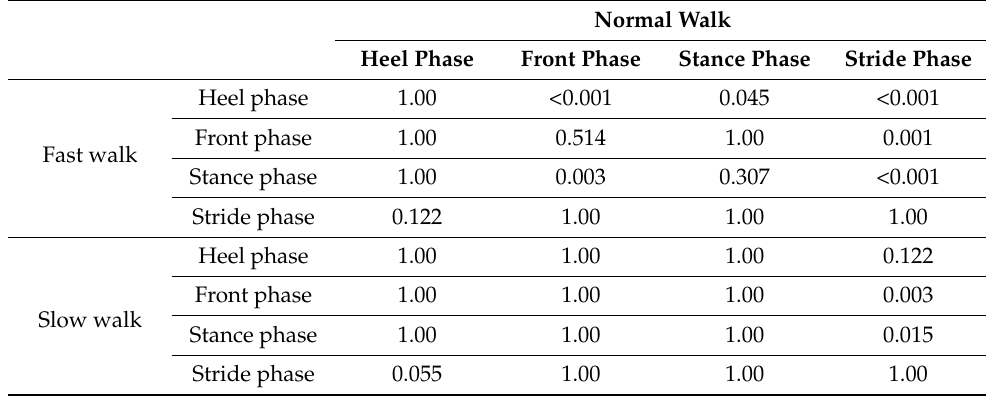
Table A5. Significance of post hoc tests for power measured for normal walk, run, and slow walk.